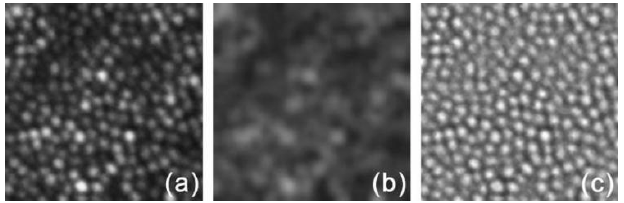
Figure 4. Bias field correction. ( a ) Denoised AO-SLO image patch. ( b ) Bias field image. ( c ) Bias-field-corrected image.